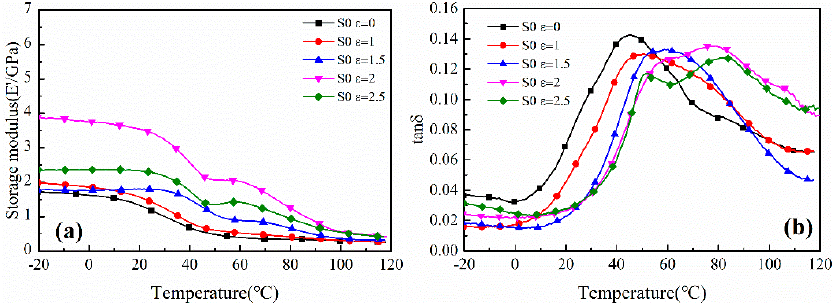
Figure 11. The ( a ) storage modulus vs. temperature and ( b ) tan δ vs. temperature curves of uniaxially stretched PA612 films.